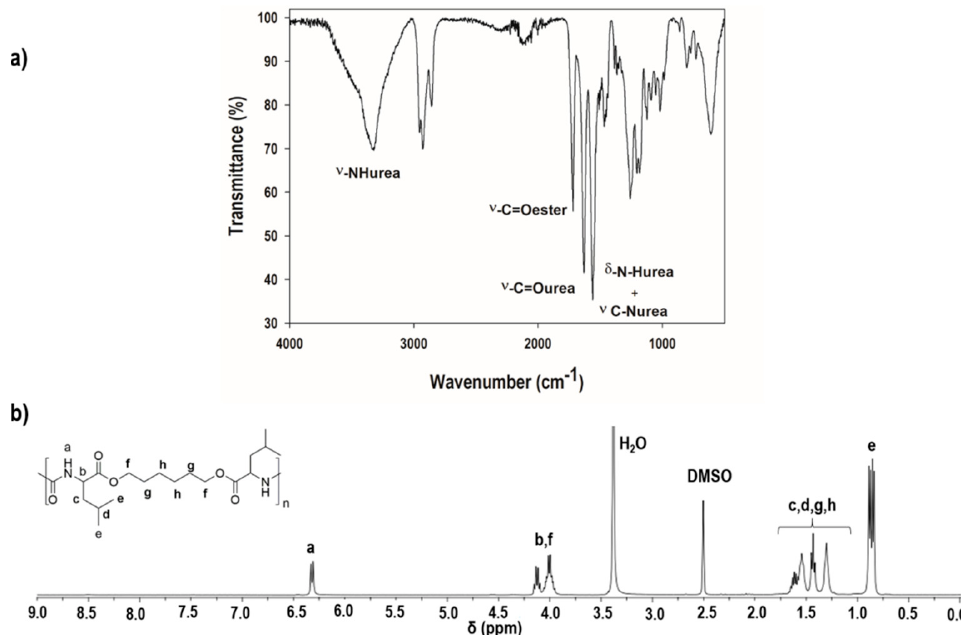
Figure 2. Spectroscopic data of the synthesised PEU demonstrating ( a ) the FTIR spectrum of PEU and ( b ) the 1 H NMR spectrum of L -leucine-based PEU.